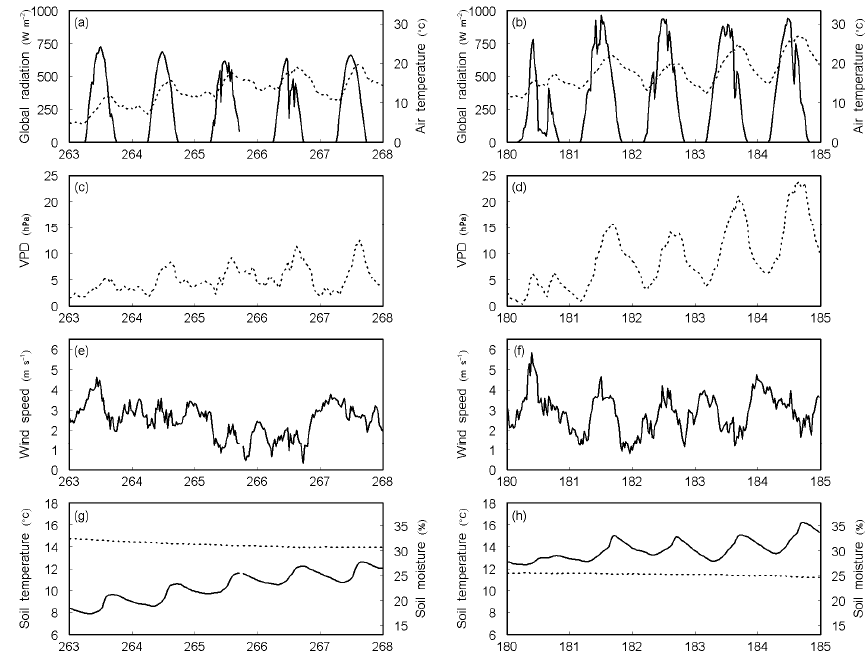
Fig. 2. Meteorological conditions during the two five day periods (left: IOP-1, right: IOP-2). (a) and (b) : Global radiation (solid line) and air temperature (dotted line) above the canopy (30m and 31m). (c) and (d) : Vapor pressure deficit above the canopy (31m). (e) and (f) : Wind speed above the canopy (31m). (g) and (h) : Soil temperature (solid line) and soil moisture (dotted line) at 10cm depth.